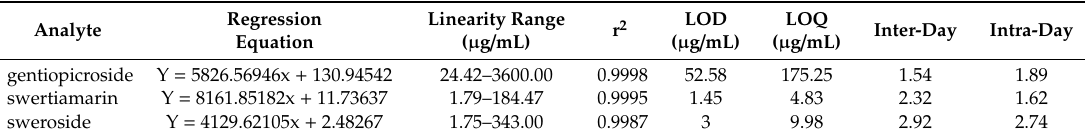
Table 2. The regression equation, linearity range, correlation coe ffi cient (r 2 ), LOD, LOQ, inter-day, and intra-day standards.